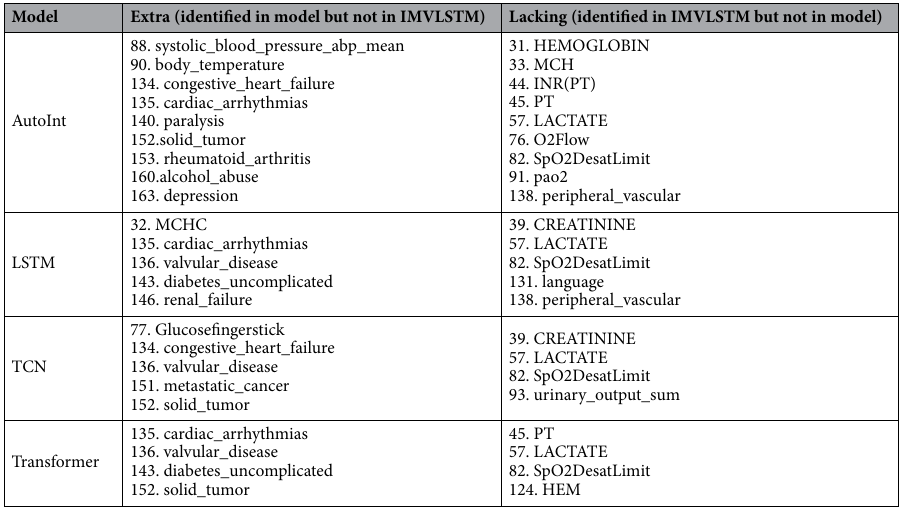
Table 4. Comparison of top-50 important features between suboptimal models and the best performing one. Importance of some comorbidities tend to be overestimated by suboptimal models, while the importance of peripheral vascular is underestimated in AutoInt and LSTM. Suboptimal models underestimate various labevent and chartevent features.